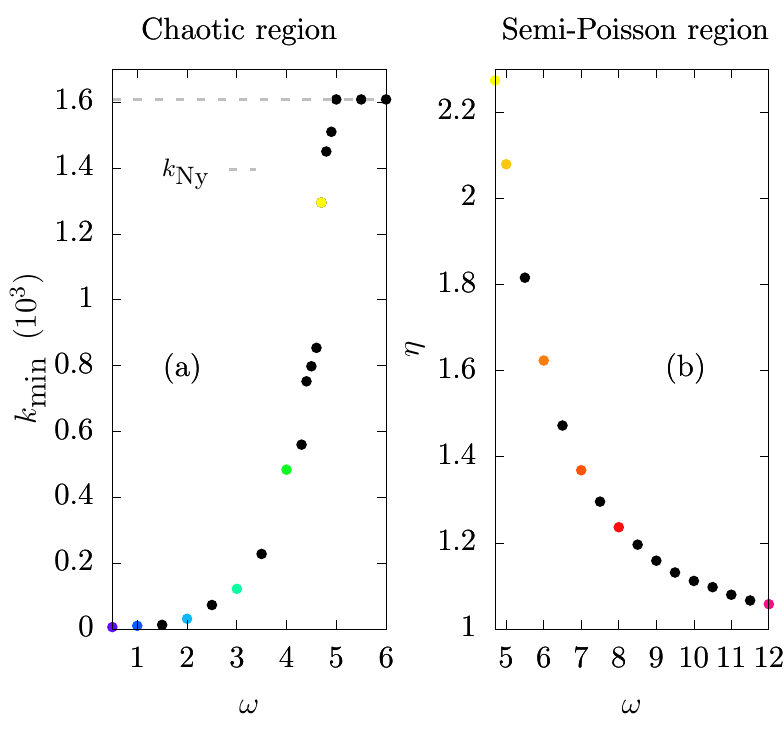
Figure 7: Behavior of long-range spectral statistics as a function of disorder ω for ( L = 16 ) , L = 16 across the transition. (a): For small values of disorder, ω (cid:174) ω c we represent the characteristic frequency k as a function of ω and compare to the min = N / 2 (gray, dashed line). A small k Nyquist frequency k corresponds to a large Ny min ( L = 16 ) Thouless energy and vice versa. (b): For large values of disorder, ω (cid:166) ω c